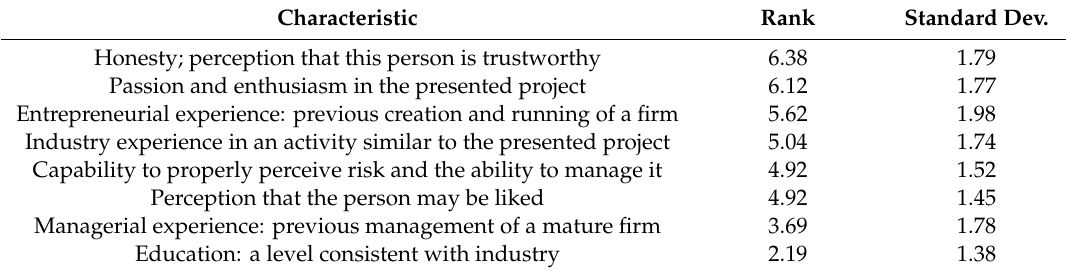
Table 8. Importance of eight characteristics according to the VC managers in this